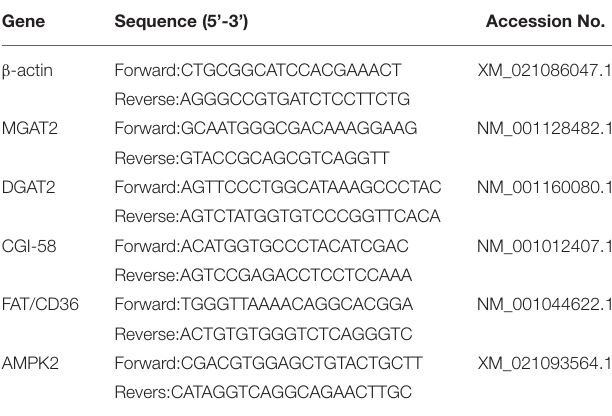
TABLE 1 | Sequences and parameters of specific primers for real-time